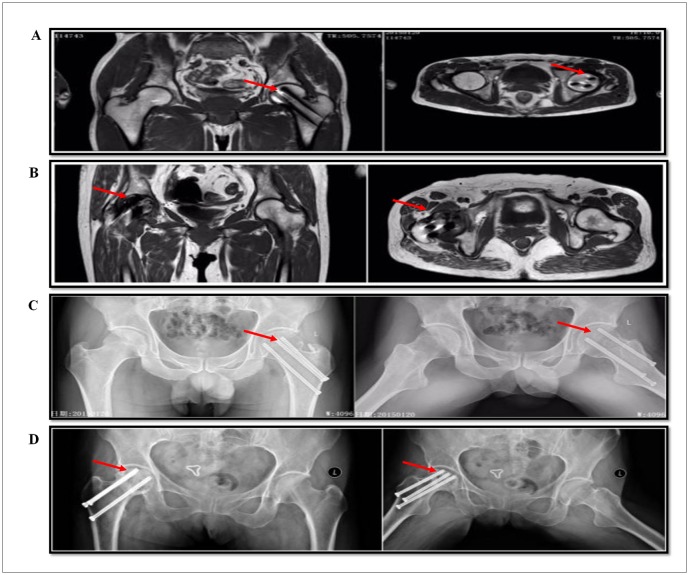
MRI and X-ray examination of TIONFH patients and the patients without necrosis.(A) MRI of patients without necrosis showed hollow spike-like images without a significant “double line”. (B) Necrosis patients showed a clear “double line” sign and displayed high signals on fat-suppressed images. (C) X-ray of patients without necrosis showed a smooth surface without collapse. (D) Necrosis patients showed femoral head collapse, density changes, cystic changes, or hollow or pierced femoral head surface.